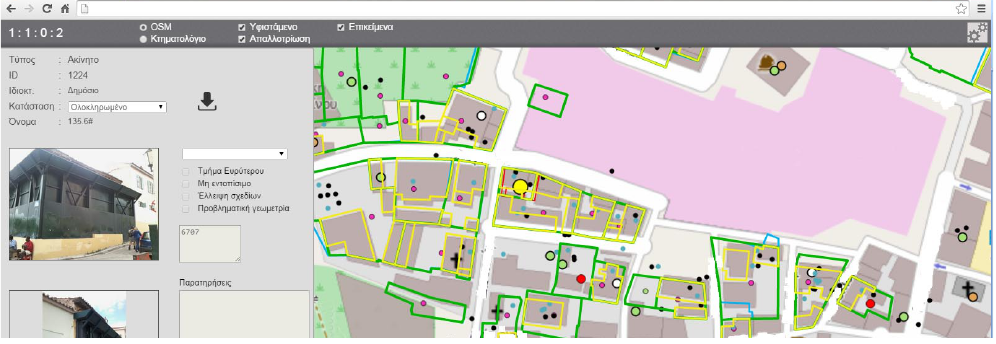
Figure 17: Created geometries as desktop client overlays on OSM